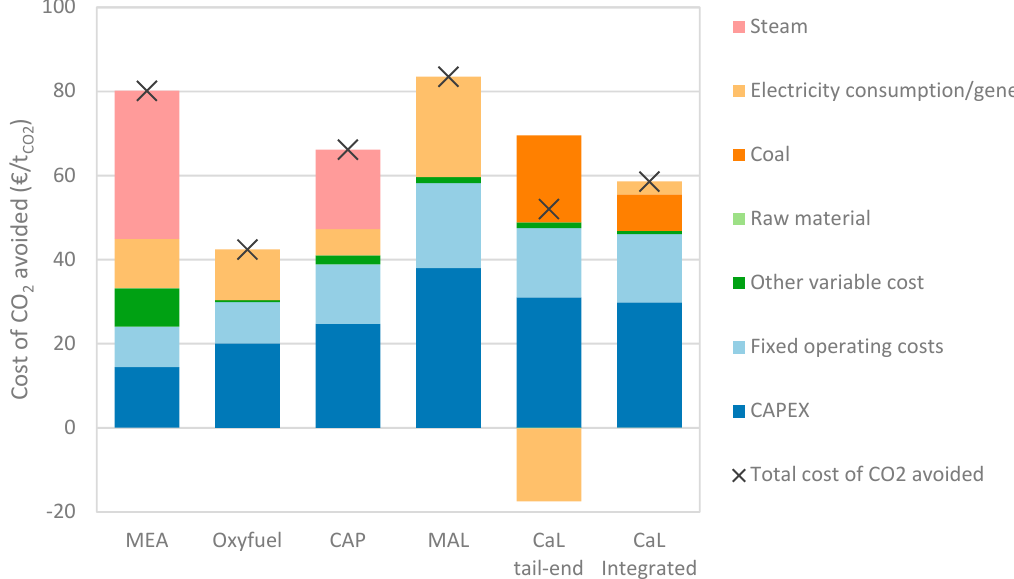
Figure 5. Break-down of cost of CO 2 avoided for all the investigated CO 2 capture Figure 5 . Break-down of cost of CO 2 avoided for all the investigated CO 2 capture technologies.